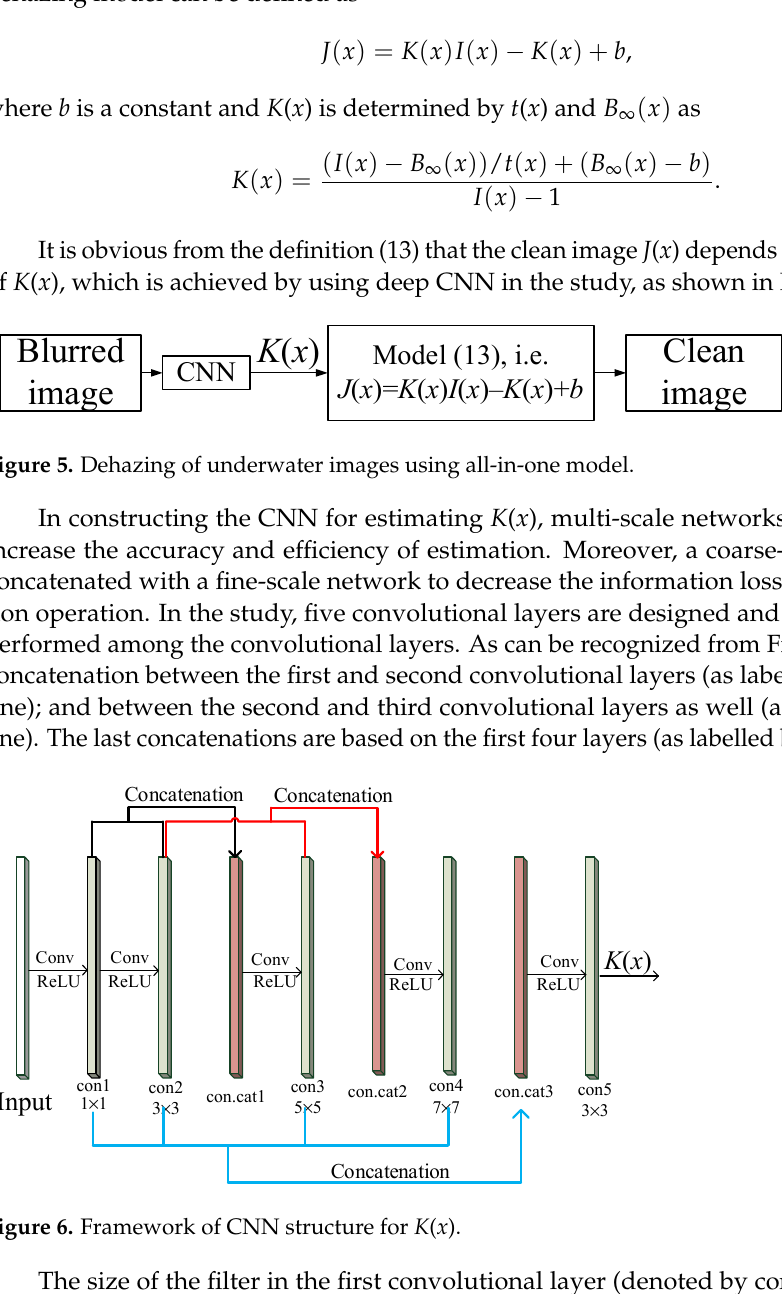
Figure 6. Framework of CNN structure for K ( x ). The size of the filter in the first convolutional layer (denoted by con1 in Figure 6) is selected as 1 × 1, 3 × 3 in the second layer (con2), 5 × 5 in the third layer (con3), 7 × 7 in the fourth layer (con4); and 3 × 3 in the last layer (con5). The activation function is selected as RELU. Furthermore, to guarantee that the size of the output is the same as the input image, in the study the padding varies with the size of the filter in different convolutional layers, which simplifies the network structure, compared with the required pooling and upsam- pling operation in the case of constant padding. According to the relationship in the convolution operation that is 2